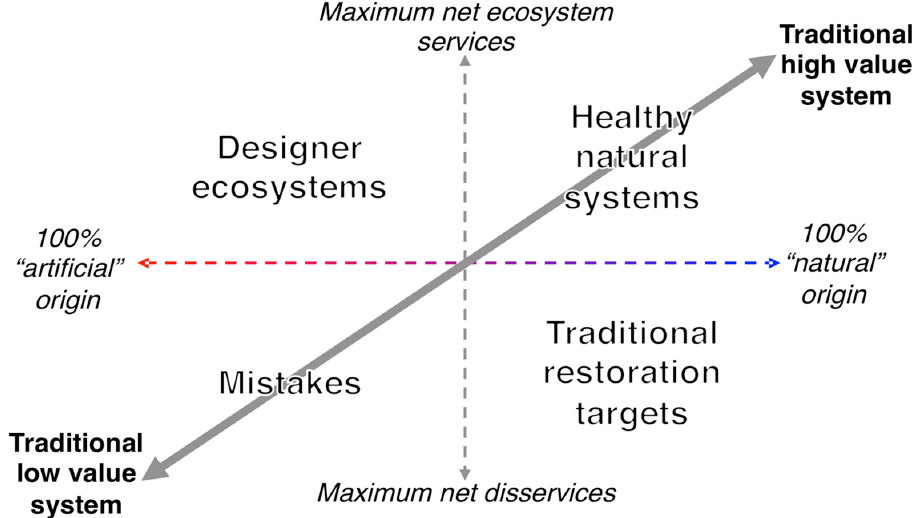
Figure 4. Value axes for aquatic ecosystems. The solid line represents a traditional axis for the value of aquatic ecosystems. The dashed lines parse out artificiality from ecosystem services provisioning along this traditional axis.